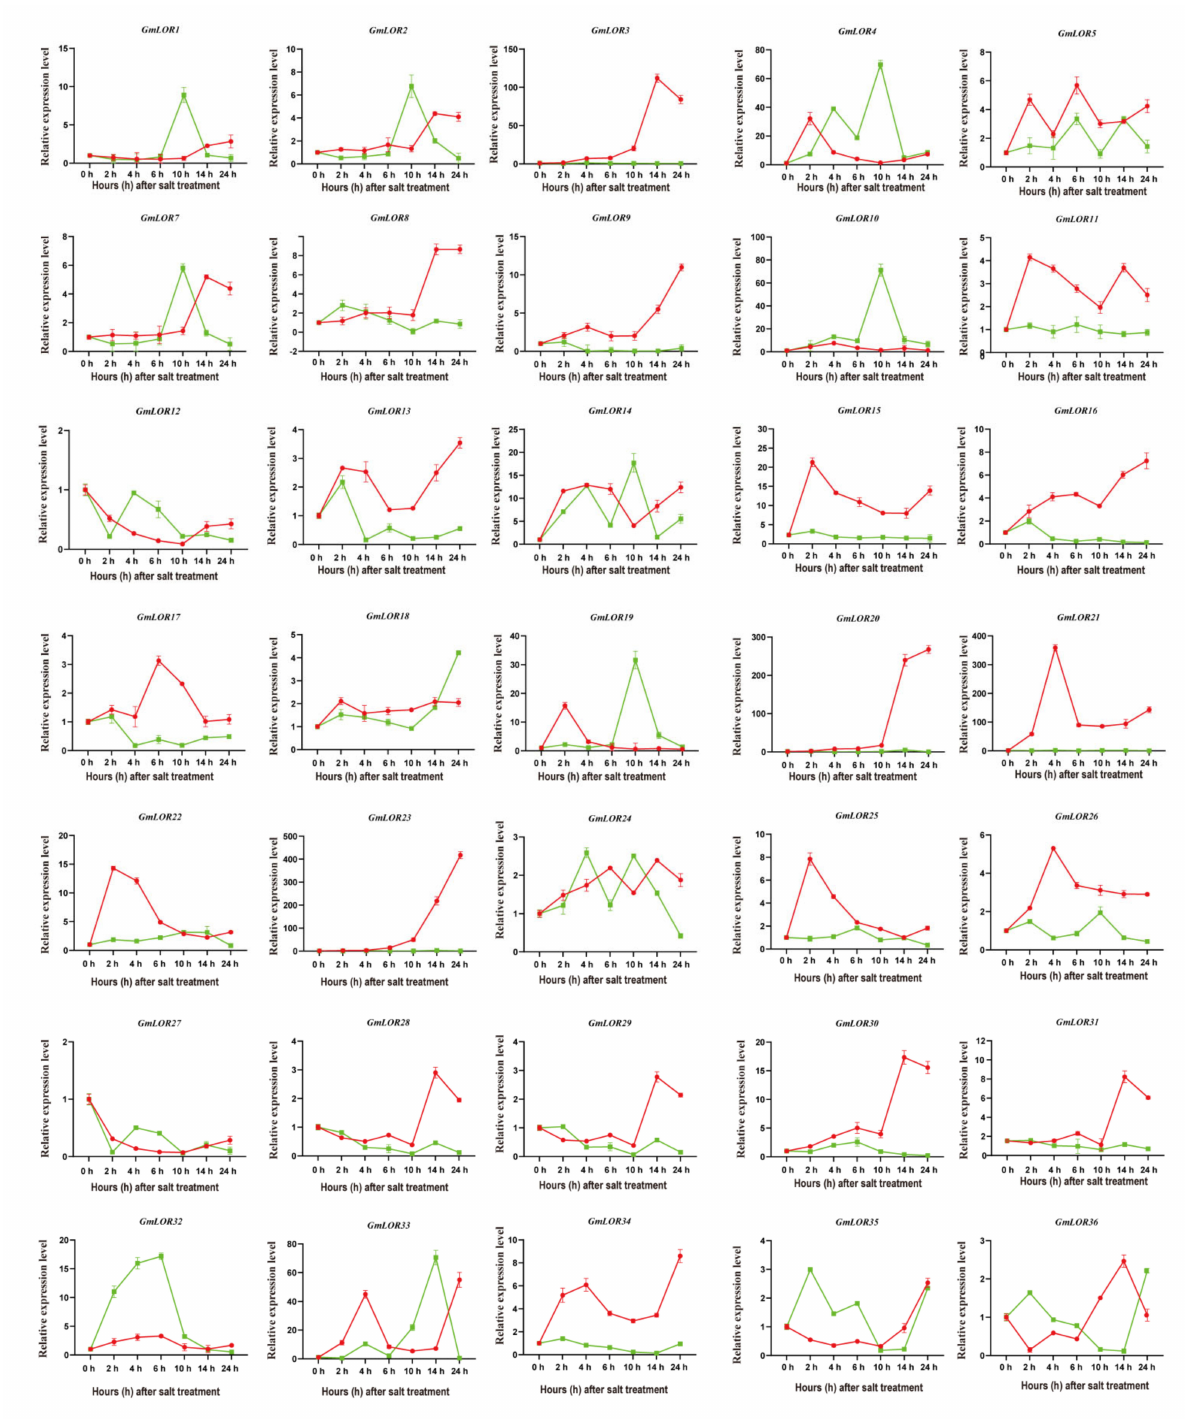
Figure 8. Relative expression levels of GmLORs in response to salt stress. The relative expression levels of 36 GmLOR genes at 2, 4, 6, 10, 14, and 24 h were determined by qRT-PCR in comparison with 0 h (the expression was set as “1”). The soybean ACT11 gene was used as the internal control. The data represent the mean ± SD of three independent biological